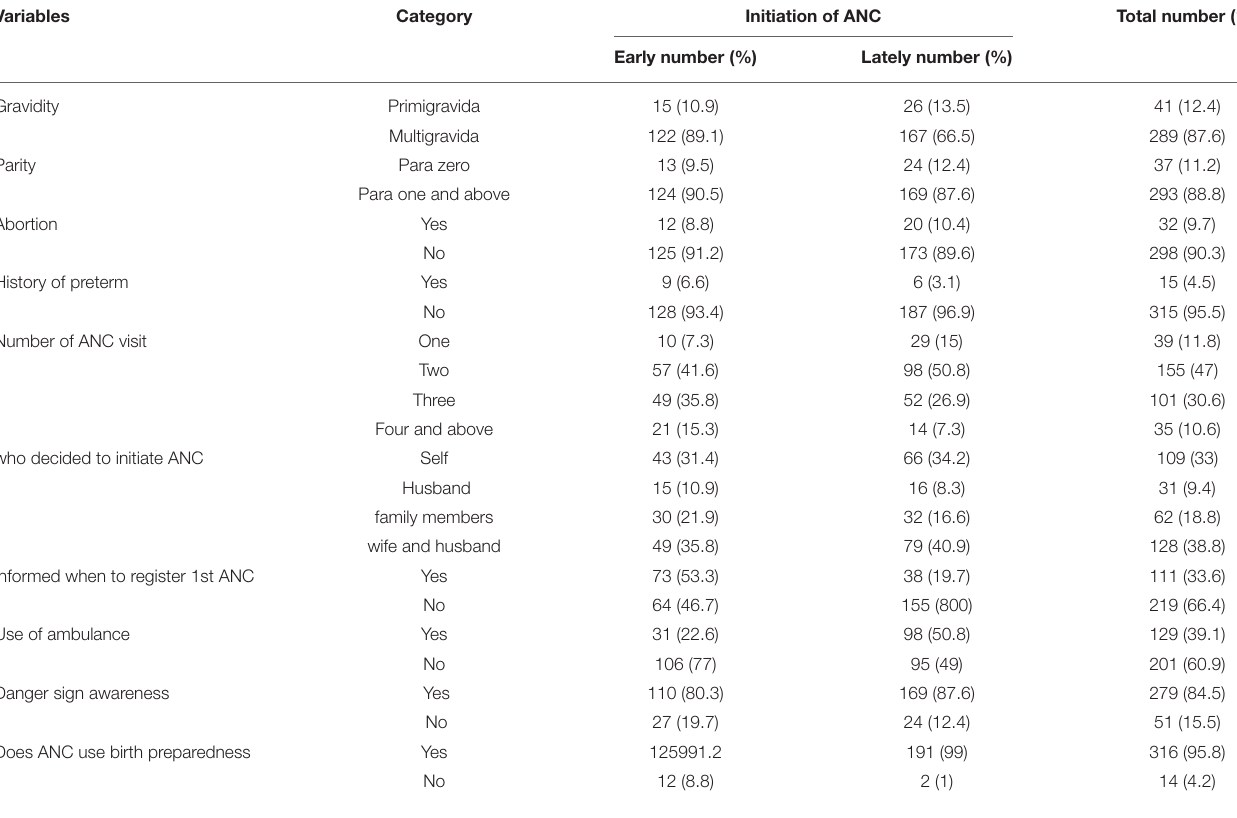
TABLE 2 | Obstetric history of pregnant mothers, who were attending ANC in Gedo general hospital ( n =